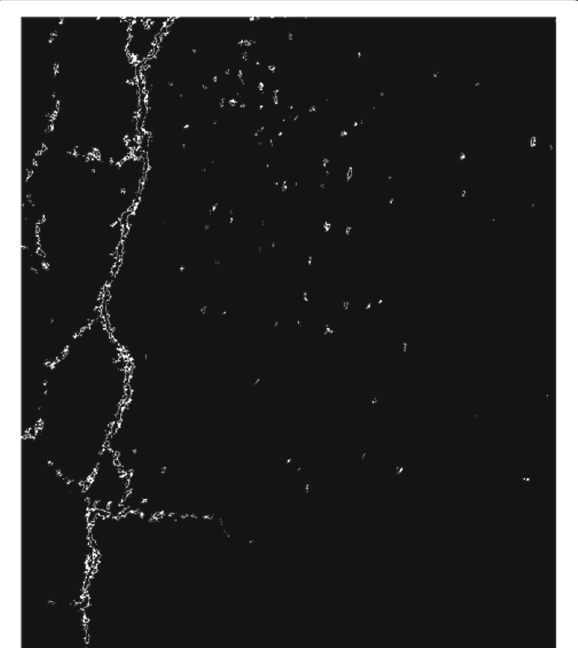
Fig. 7 Result of applying the morphological closing operator to Fig. 6. The crack was clearly defined and, in addition, now is also